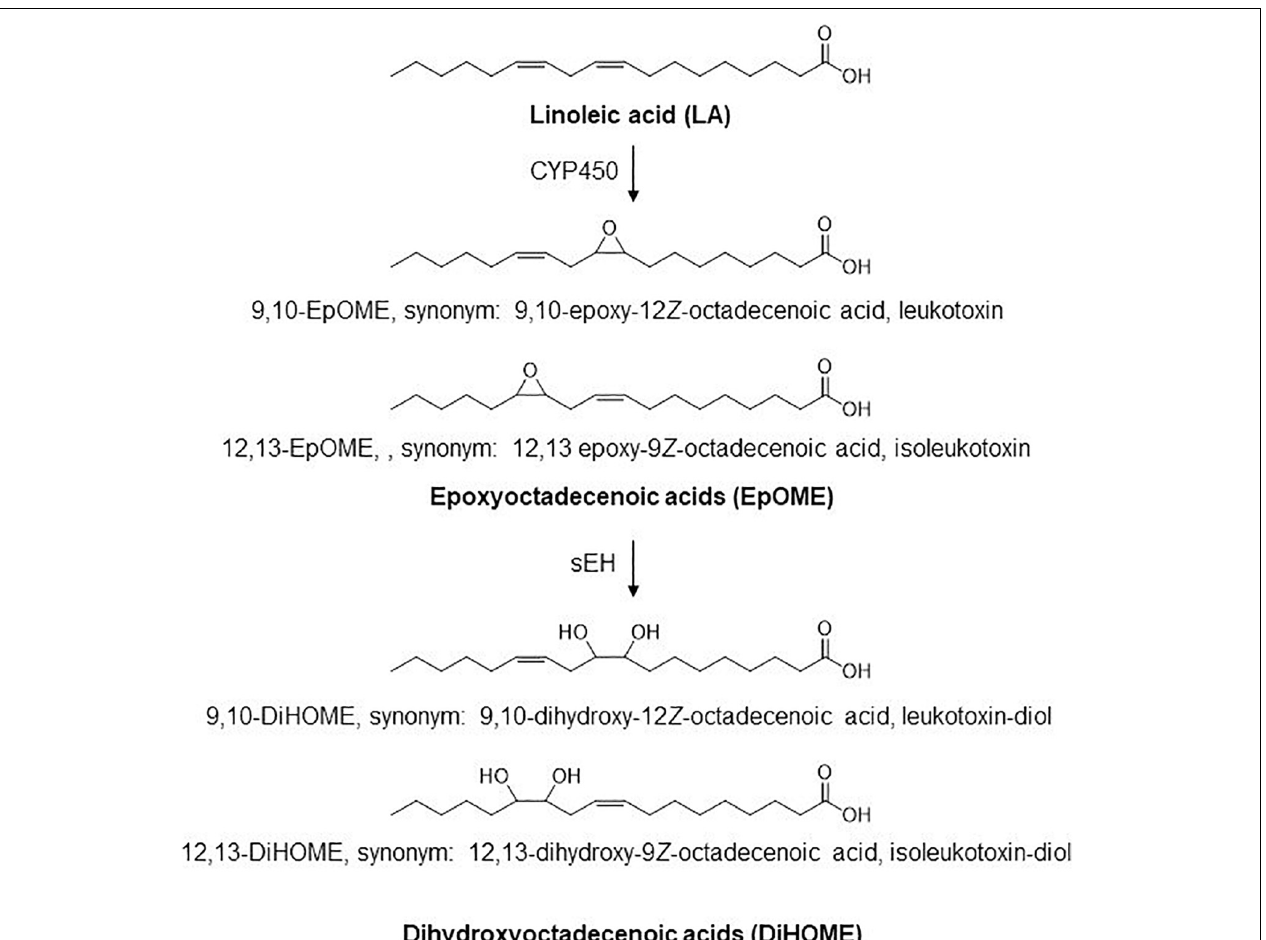
FIGURE 1 | Structure of LA, EpOmE, and